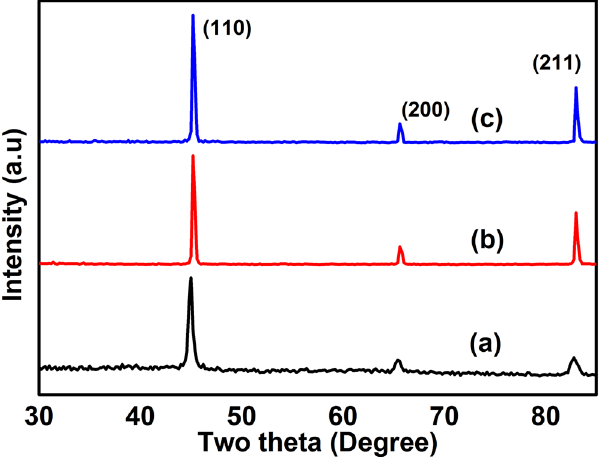
Figure 1. XRD profiles of FeCo ( a ) as-prepared ( b ) 700 and ( c ) 800 °C annealed